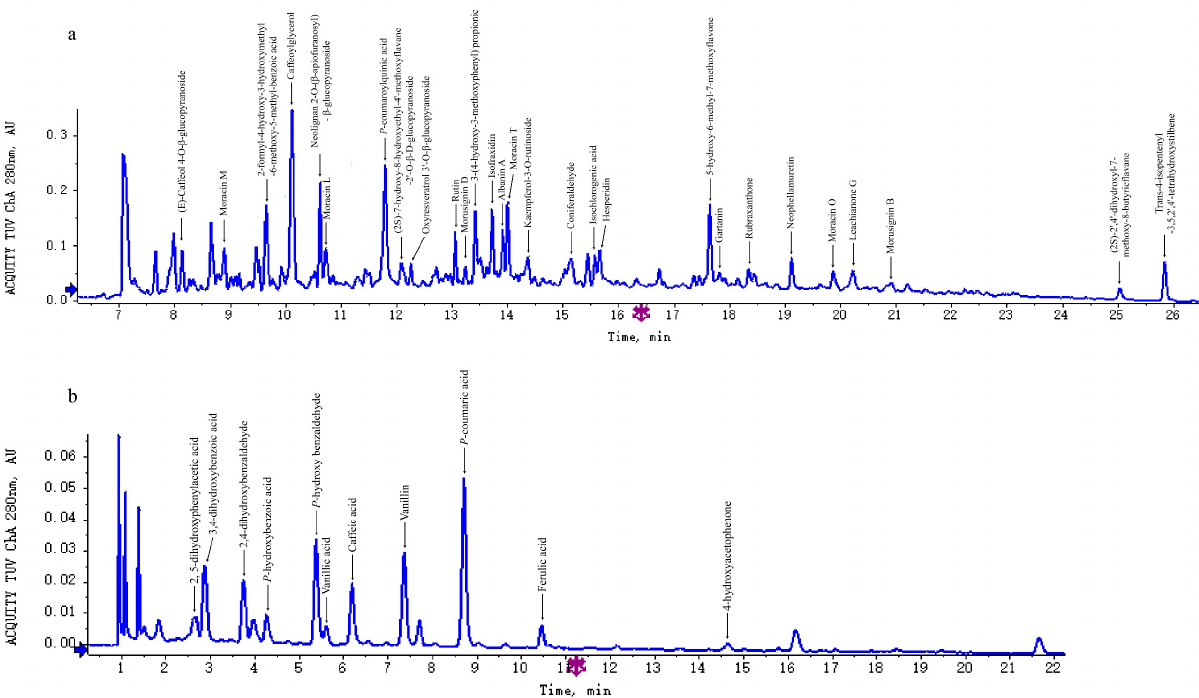
Figure 1. Representative UPLC chromatogram of FPs ( a ) and BPs ( b ) at 280 nm.